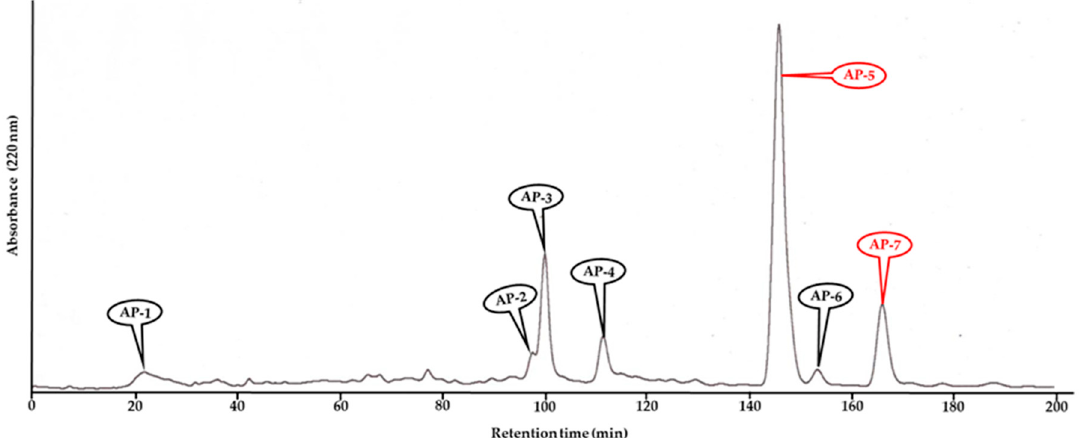
Figure 6. Chromatogram of the compounds obtained from the reverse-phase HPLC (the active compounds are marked in red).